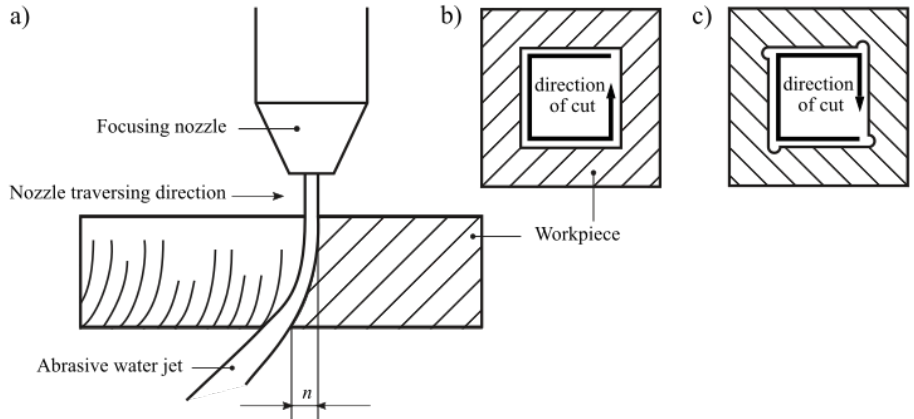
Figure 1. Phenomena occurring during material cutting with high-pressure abrasive water jet (AWJ), important in the context of the quality of this process—deviation of the AWJ: ( a ) graphical interpretation of the phenomenon; ( b ) workpiece top view; ( c ) workpiece bottom view with errors in the shape of corners caused by the jet lag.